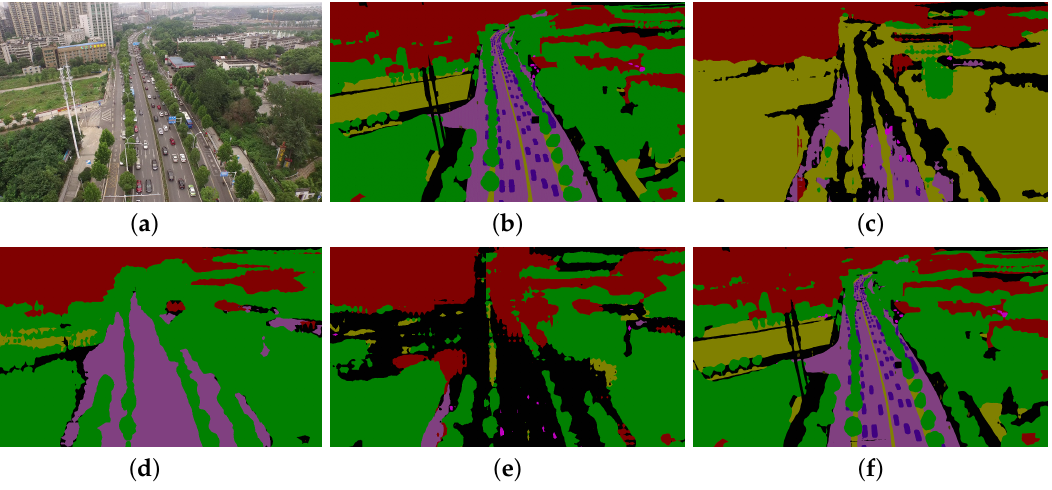
Figure 5. Visualization results of different methods on adversarial example test set in UAVid